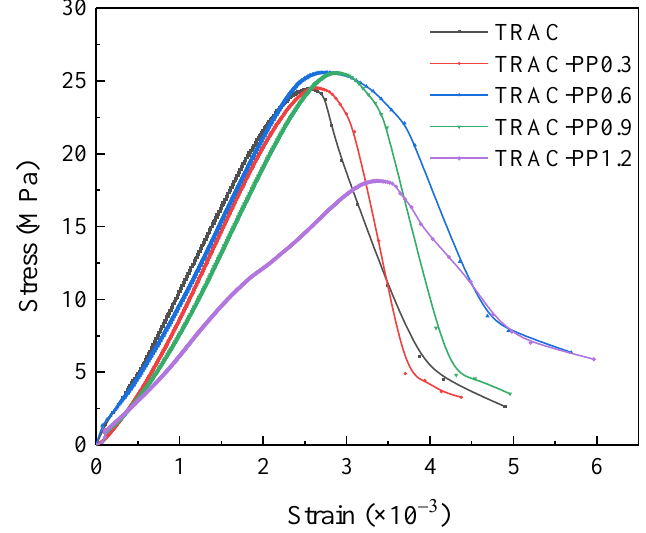
Figure 4. The compression stress-strain curves of specimens.